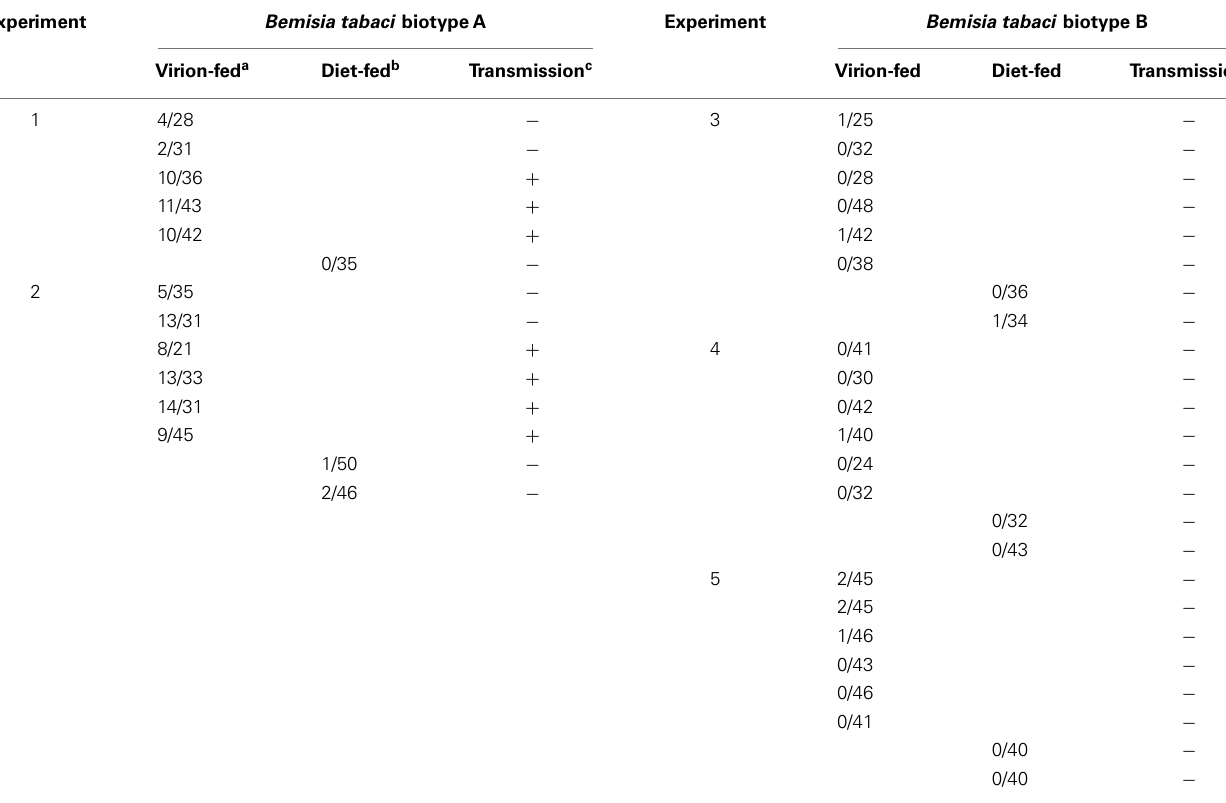
Table 2 | Correspondence between quantum dot signals in the anterior foregut or cibarium of Bemisia tabaci and successful LIYV transmission.